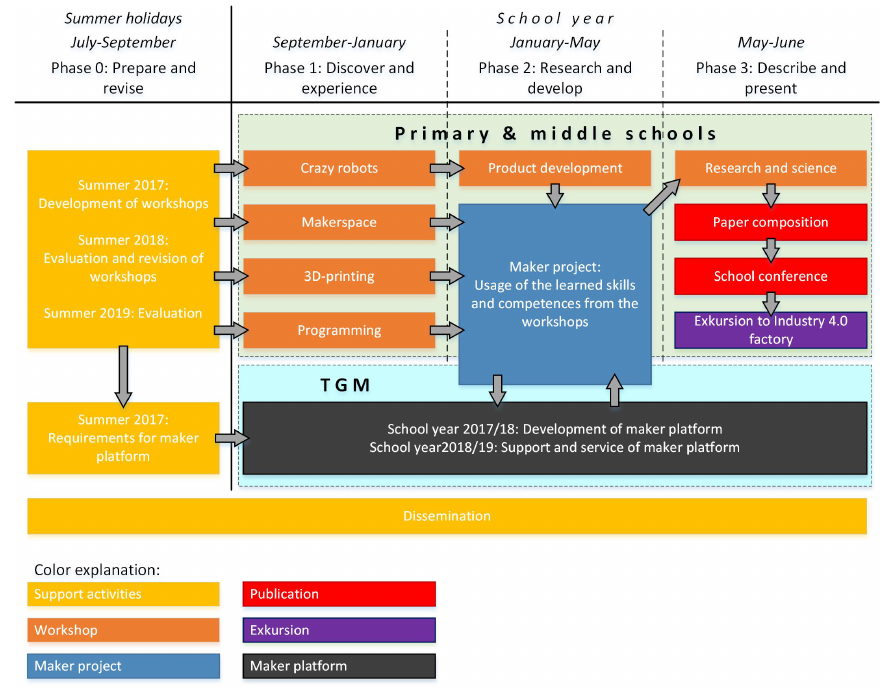
Fig. 6. Overview of the activities of the project